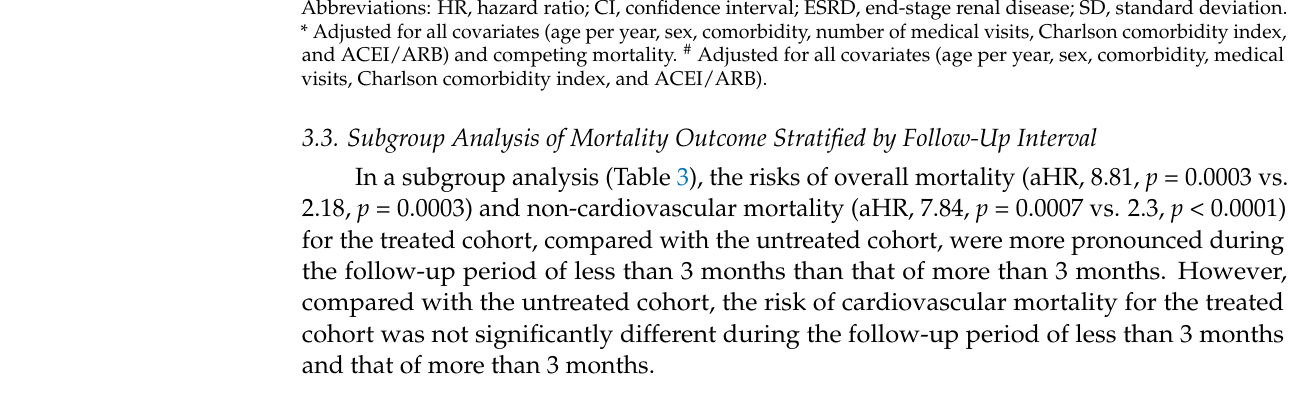
Table 3. Association between surgical treatment for obstructive sleep apnea and mortality outcomes stratified by follow-up